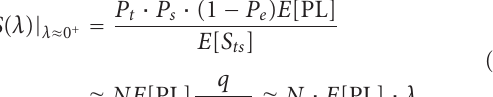
Upon substituting (10) in (7), the theoretical throughput